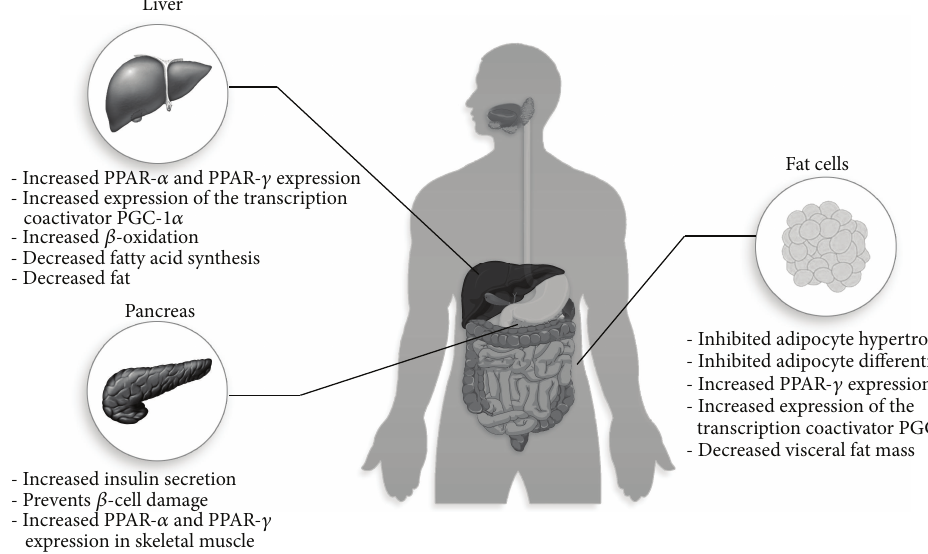
Figure 5: Effect of bitter melon on various organ and probable molecular targets for improving obesity and